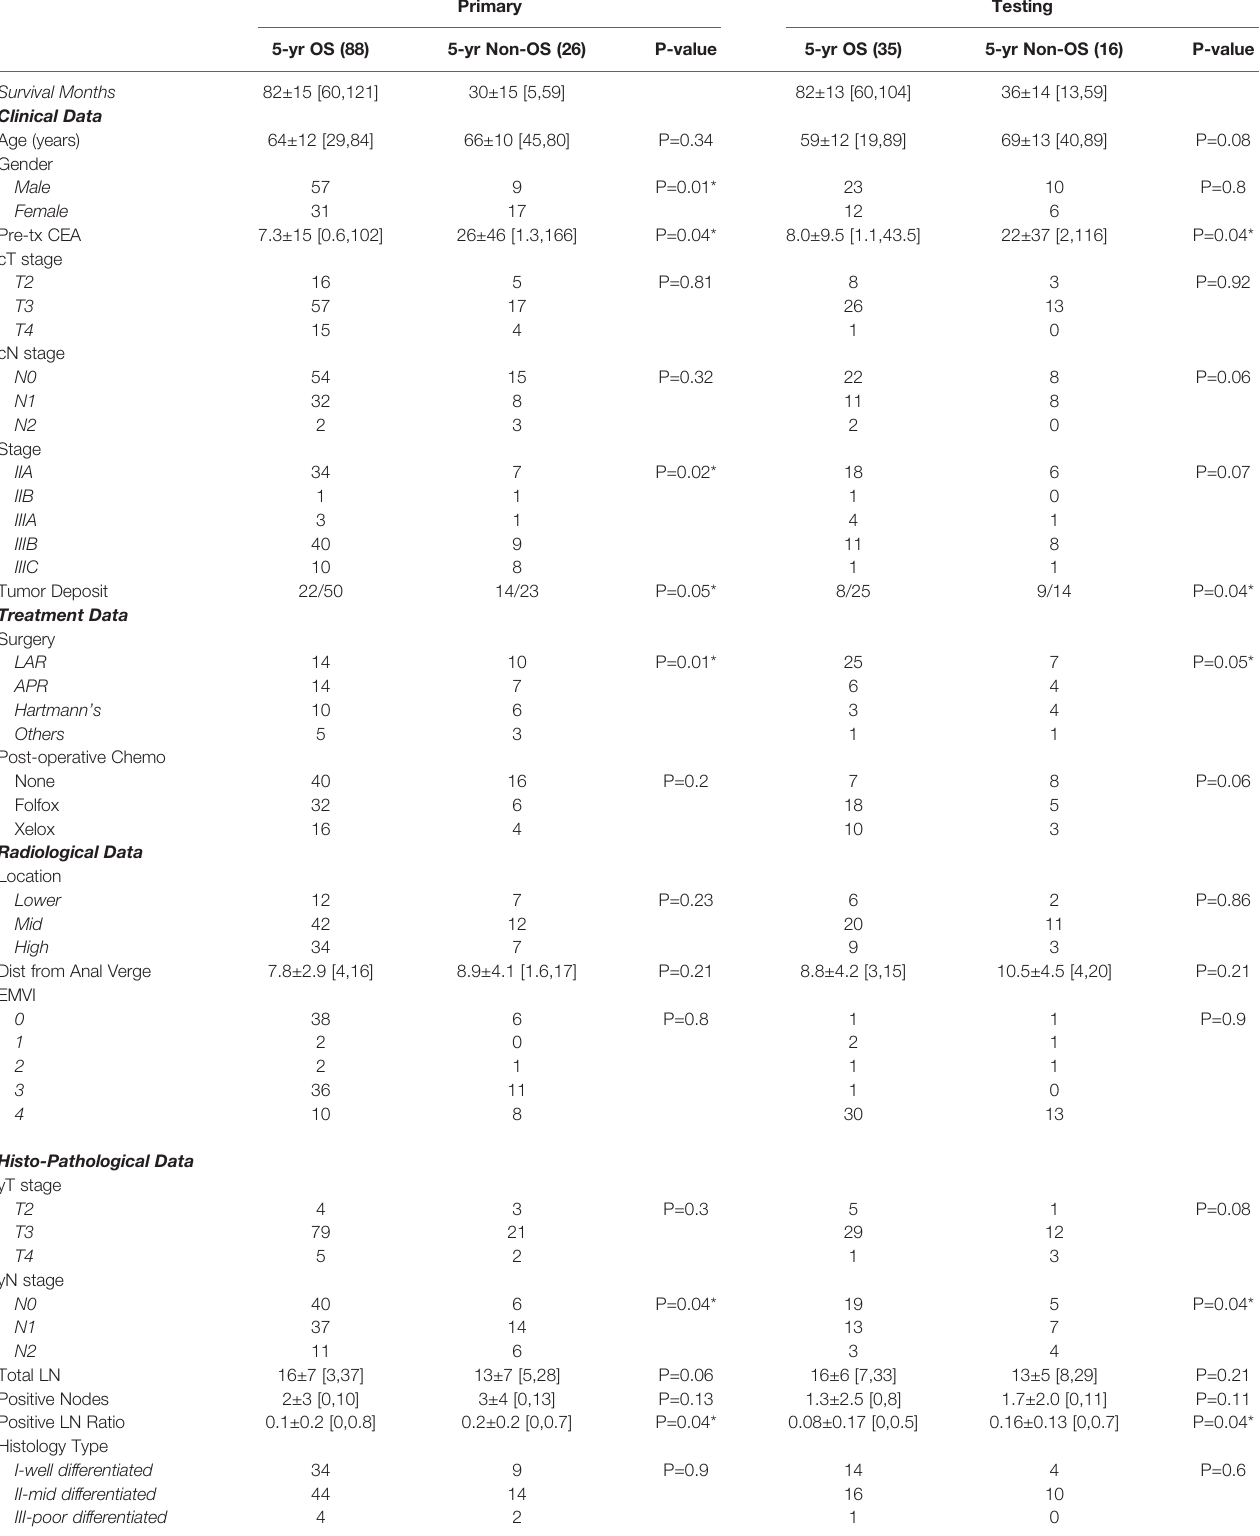
TABLE 1 | Patient